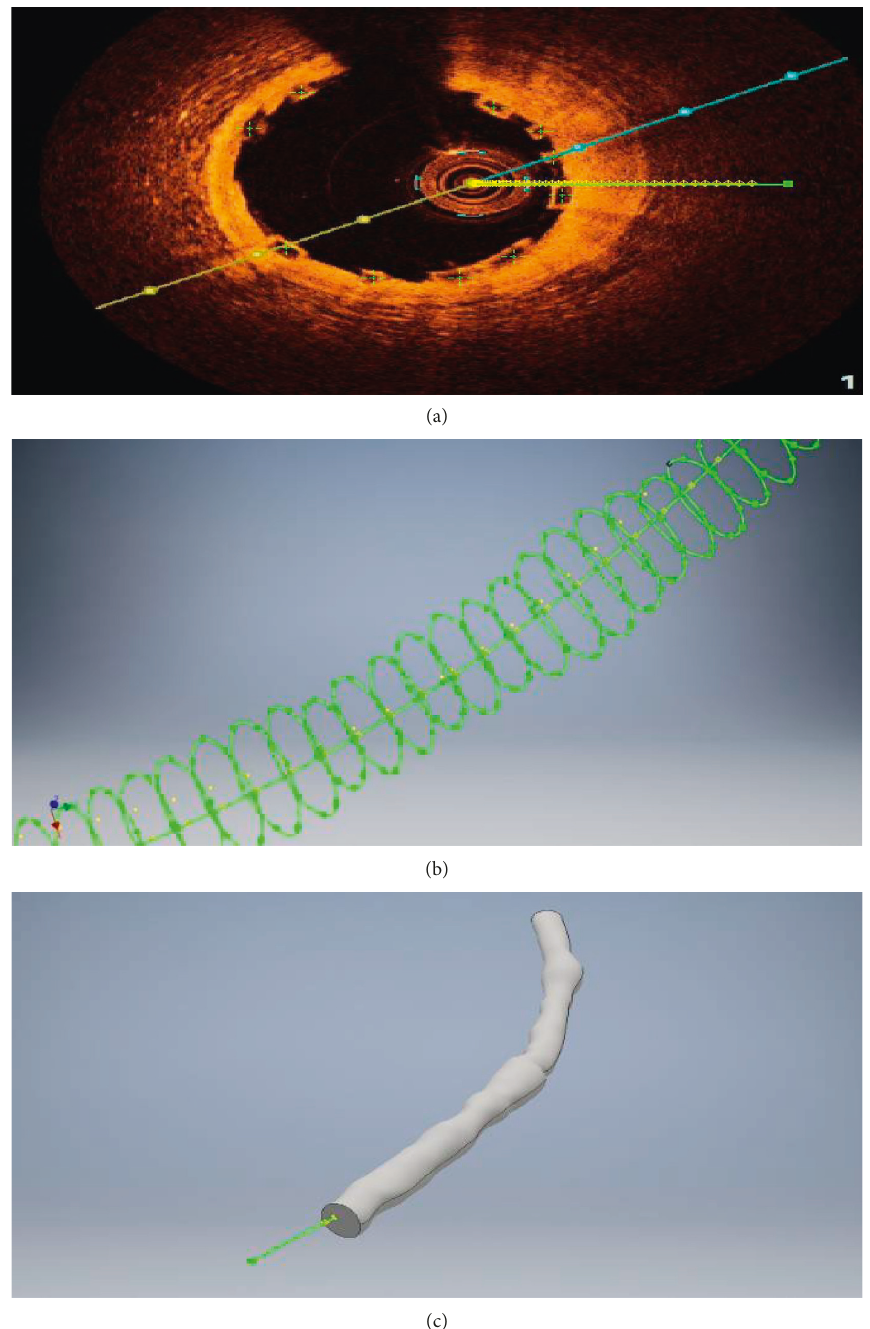
Figure 2: (a–c) Fusion IVOCT and CAG images of vascular three-dimensional model